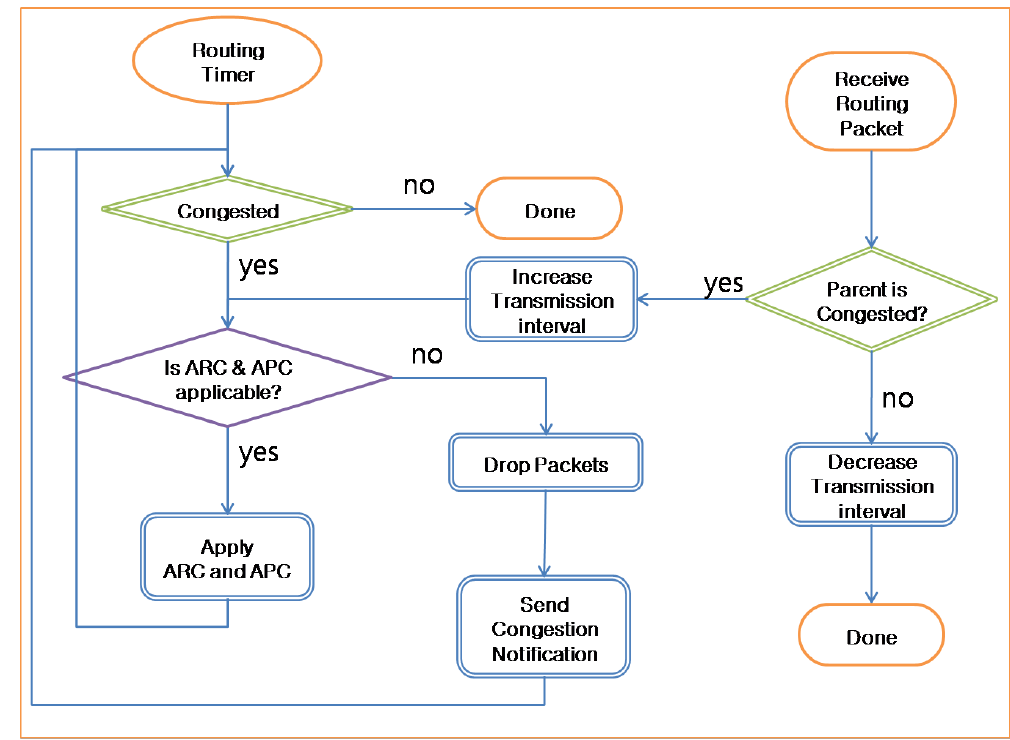
Figure 9. Operation of